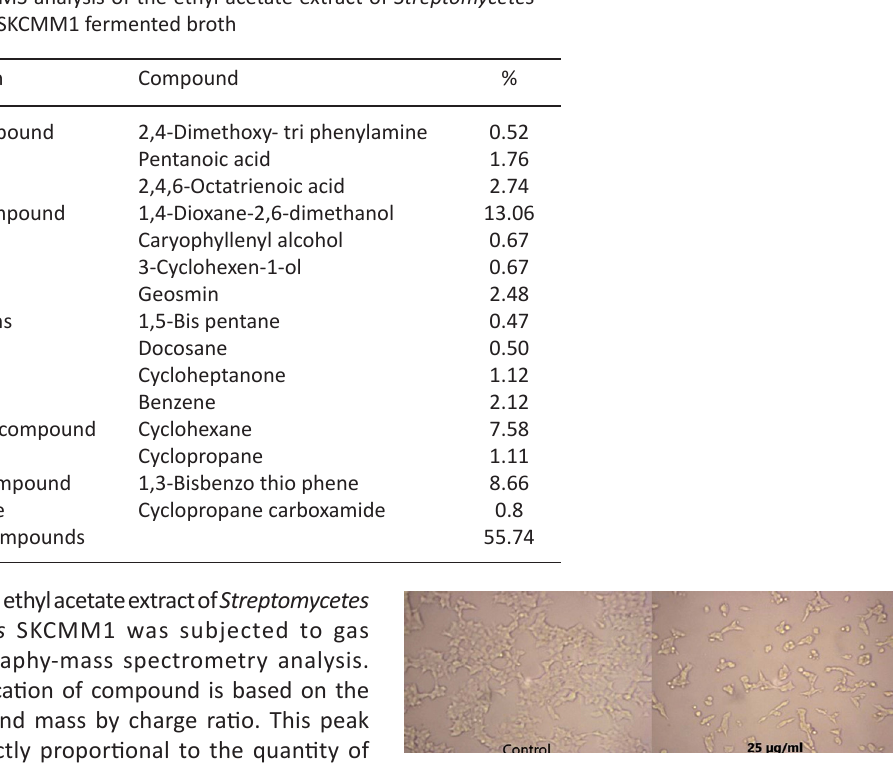
Fig. 7. Anticancer activity of the crude extract of Streptomyces cavourensis SKCMM1 against cancer cell lines